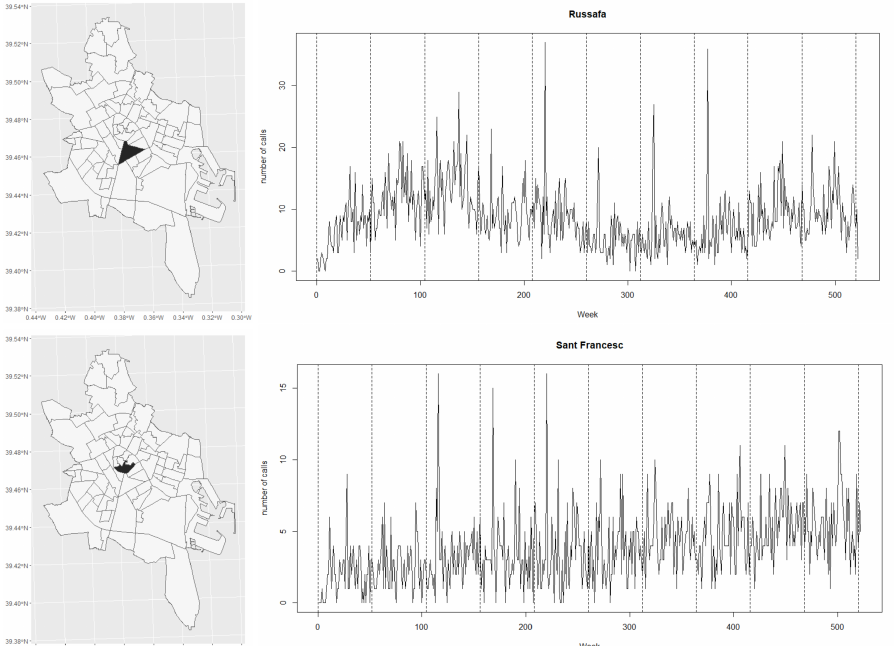
Figure 3. Weekly calls distribution over time at central districts in Valencia, Russafa (top row), and Sant Francesc (bottom row).